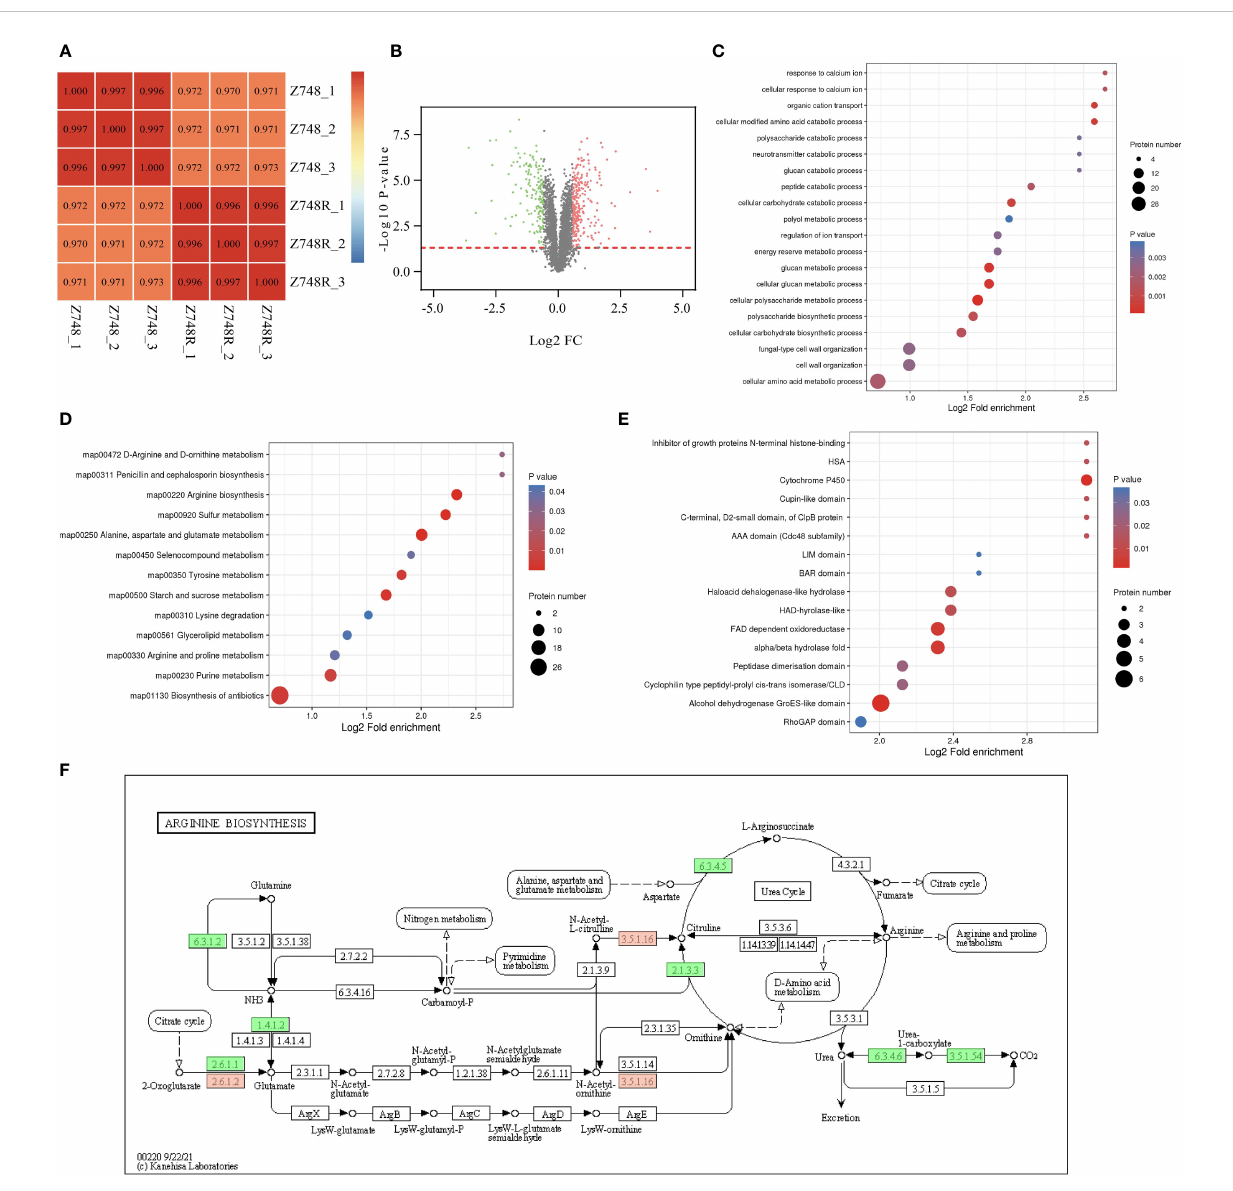
FIGURE 4 Comparative Proteomic analysis between Z748R and Z748. (A) Heatmap of Pearson ’ s correlation coef fi cient. (B) Volcano plot of DEPs between Z748 and Z748R. (C) GO enrichment analysis of DEPs. (D) KEGG pathway enrichment analysis of DEPs. (E) Protein domain analysis of DEPs. (F) DEPs involved in arginine biosynthesis pathway.